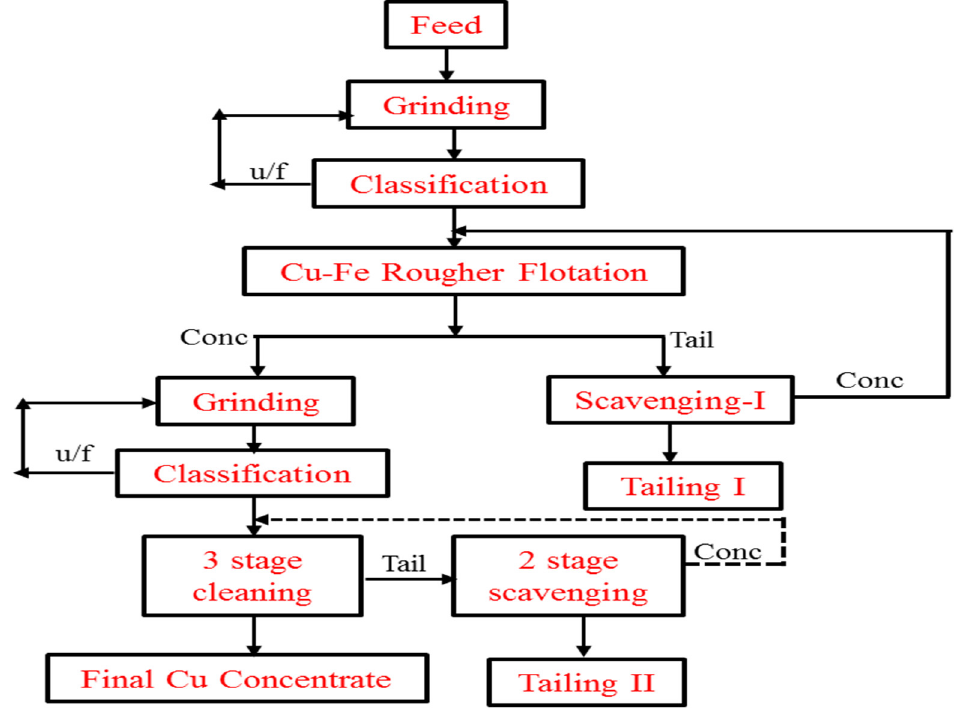
Figure 20. The flow sheet of bulk flotation by separation in the Dexing Copper Mine [71].